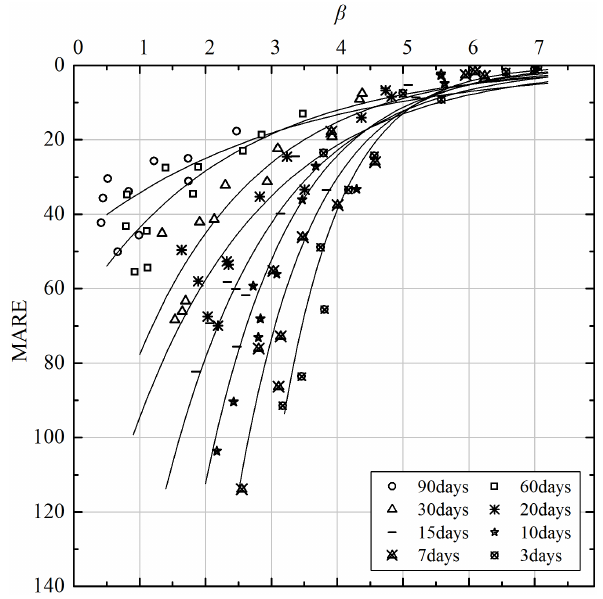
Fig. 8. Scatter plots of β and MARE. The curves are fitted exponen- tial lines for each group of forecasts with the same forecast window. Figure 8. Scatterplots of β and MARE . The curves are fitted exponential lines for each group of 623 The parameters of the lines are summarized in Table forecasts with the same forecast window. The parameters of the lines are summarized in Table 4. 624 625